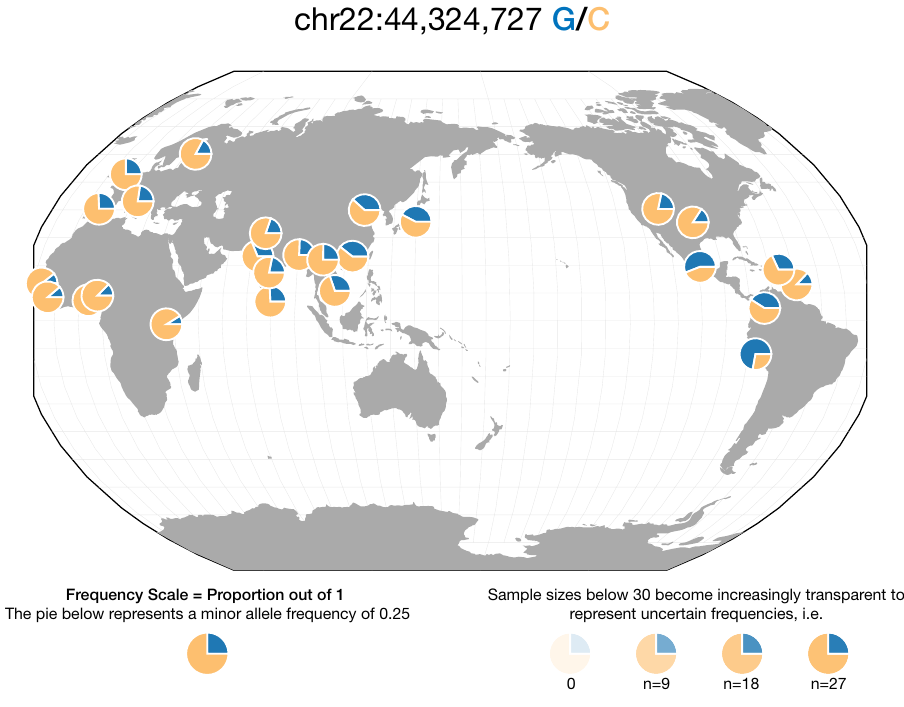
Fig 5. The distribution of the PNPLA3 I148M variant (blue) worldwide shows the greatest enrichment in populations from Central and South America, while being a common variant in all populations.